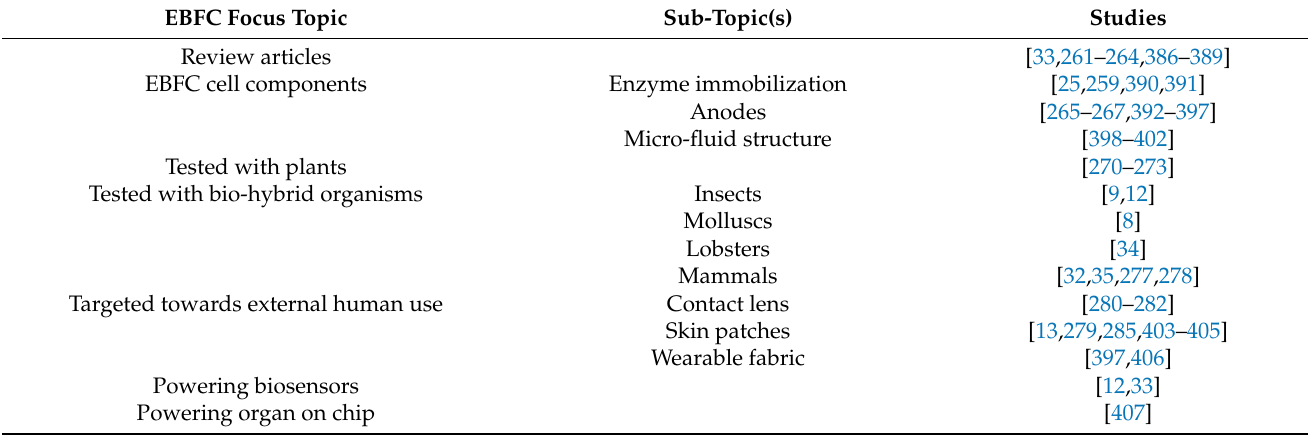
Table 2. Summary of reviewed works on enzyme-based fuel